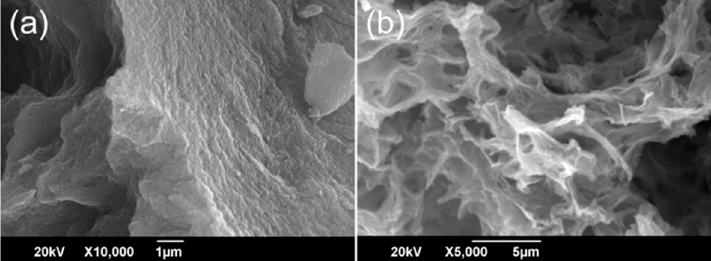
Figure 3. SEM images of Ru/graphene nanocomposites prepared by drying under air ( a ) and freeze ‐ drying ( b ).